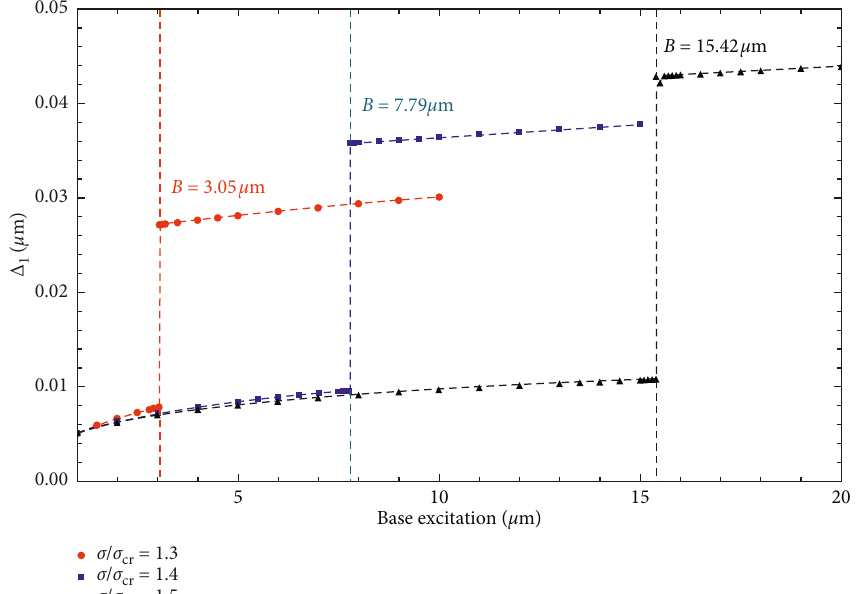
Figure 8: Variation of main beam elongation versus base excitation for three different initial buckling stress levels at 115 Hz excitation frequency.